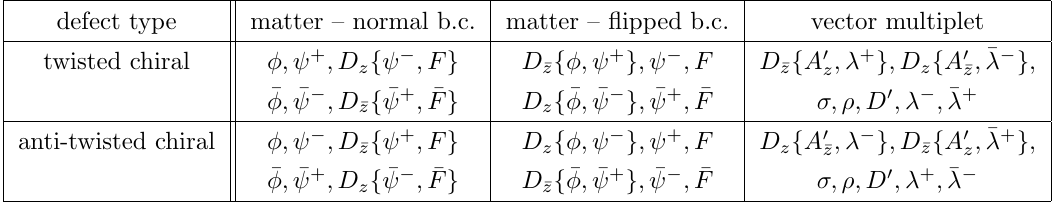
and Q (cid:6) = Q G = 0. Let primed (cid:12)elds A 0 A A vortex defect con(cid:12)guration. We obtain the groups of (cid:12)elds obeying the same